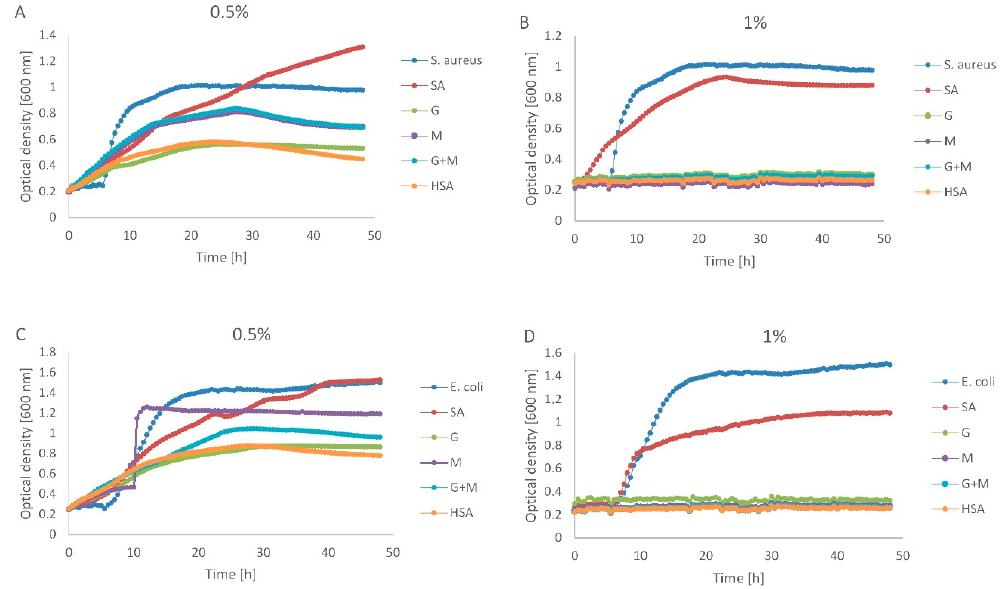
Figure 6. Growth curves of Staphylococcus aureus in the presence and absence of acidic (G, M and M + G) and oxidation (HSA) depolymerization products of sodium alginate (SA) in the concentration of 0.5% ( A ) and 1% ( B ). Growth curves of Escherichia coli in the presence and absence of acidic (G, M and M + G) and oxidation (HSA) depolymerization products of sodium alginate (SA) in the concentration of 0.5% ( C ) and 1% ( D ). Points are means of three measurements.